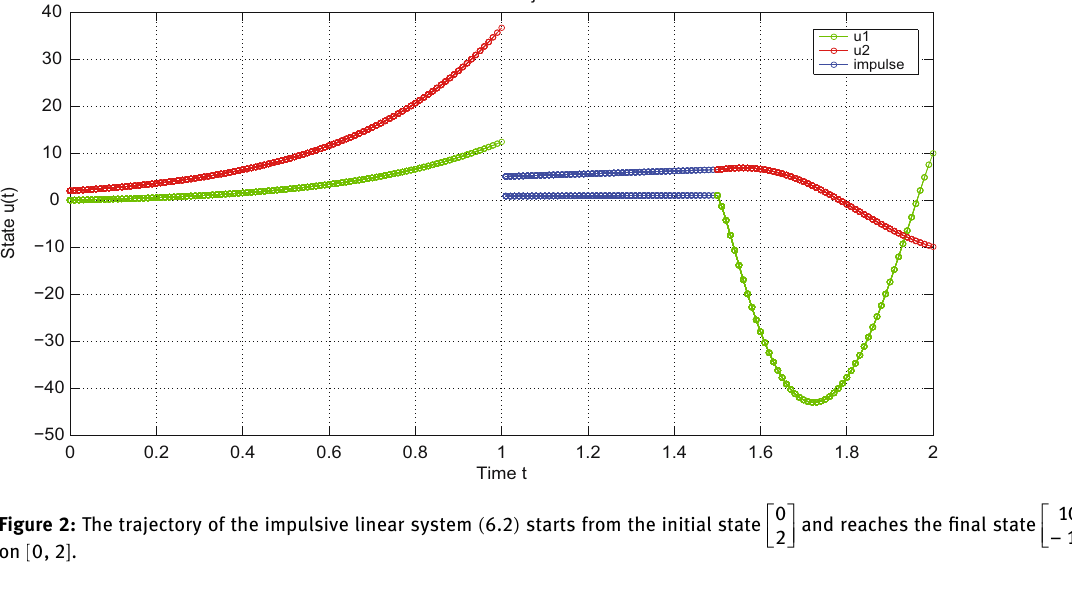
0   and reaches the fi nal state   2